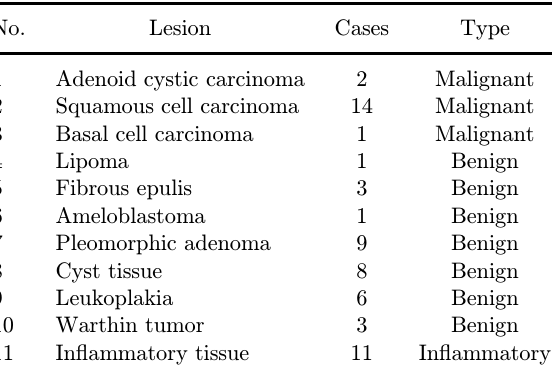
Table 1. The information of lesions.